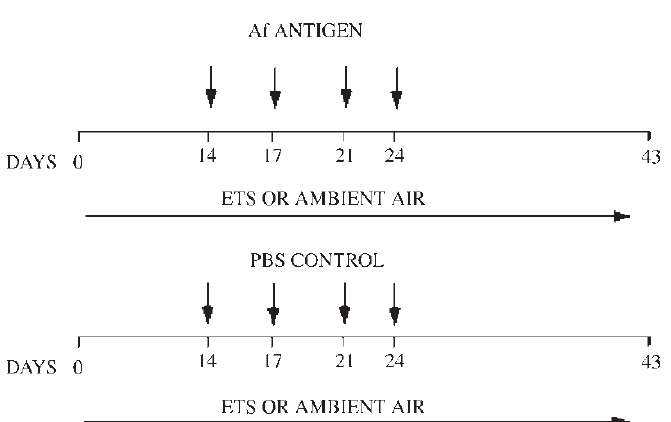
FIGURE 1 Antigen sensitization and ETS/AIR exposure